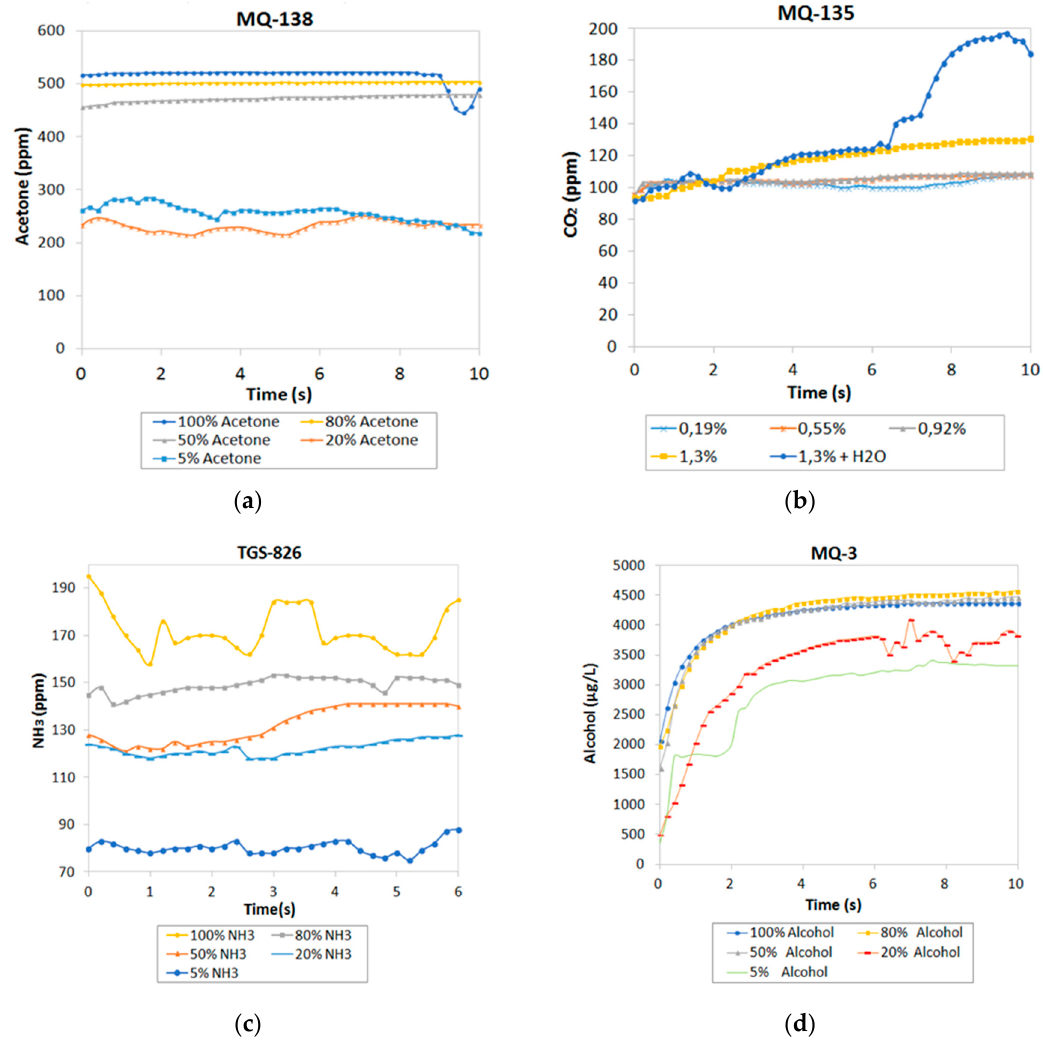
Figure 6. Evolution of gases at different concentrations: (a) acetone; (b) CO 2 ; (c) NH 3 ; (d) alcohol.